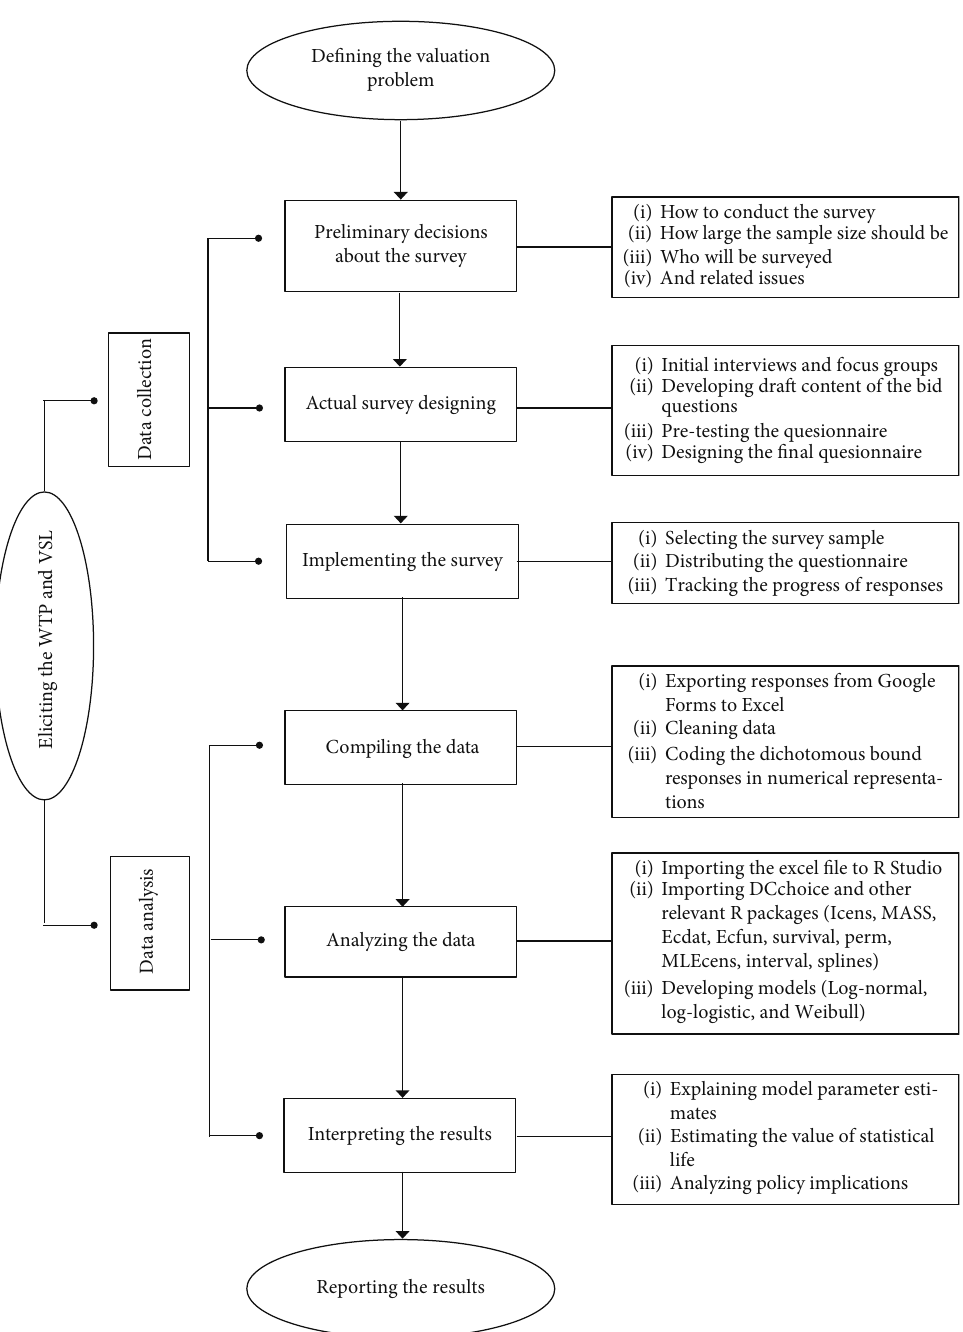
Figure 1: Theoretical framework of the study (source: